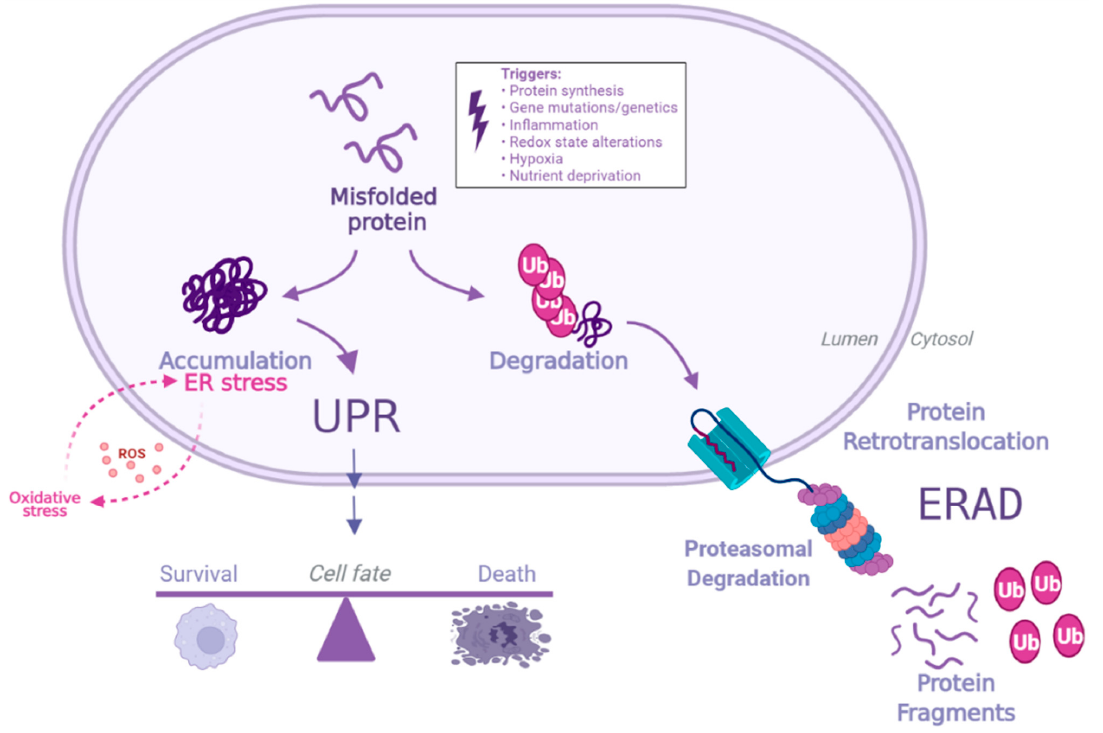
Figure 1. Protein misfolding ER stress, and the UPR. A large fraction of newly synthesized proteins commonly misfolds. Such proteins either associate with molecular chaperones to be remodeled into native proteins or can be degraded for clearance via ER-associated degradation (ERAD). When increased protein production occurs, or in the presence of cellular stressors, the ER degradation capacity can be exceeded, leading to an accumulation of proteins in the ER lumen, which causes ER stress. Such stress can induce oxidative stress, further contributing to accumulation of misfolded proteins and oxidation, creating a vicious cycle. ER stress is balanced by activation of the UPR, a process aimed at restoring homeostasis. However, if ER stress is prolonged or severe, the UPR can also promote cell death. Created with BioRender.com (accessed on 31 May